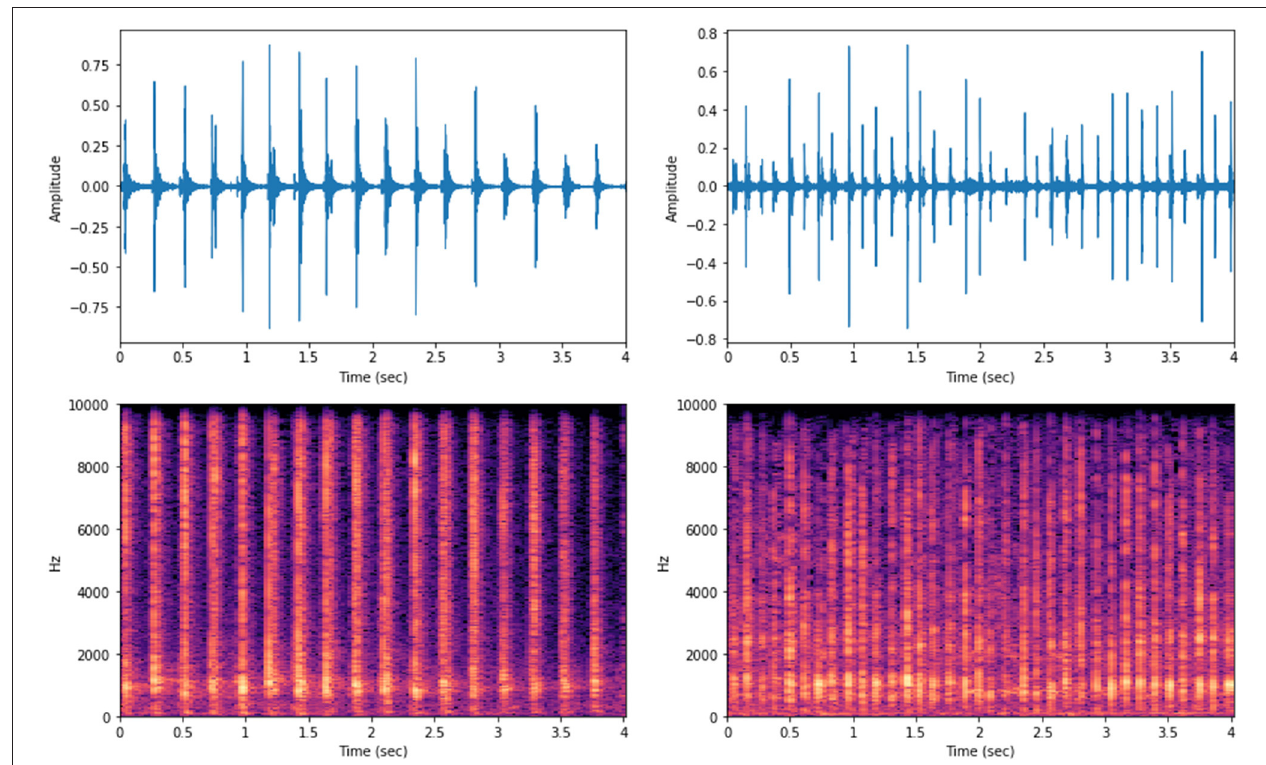
FIGURE 4 | Waveforms (top) and spectrograms (bottom) for the audio data of random samples of MB (left) and MP (right) gaiting phenotypes in Brazilian